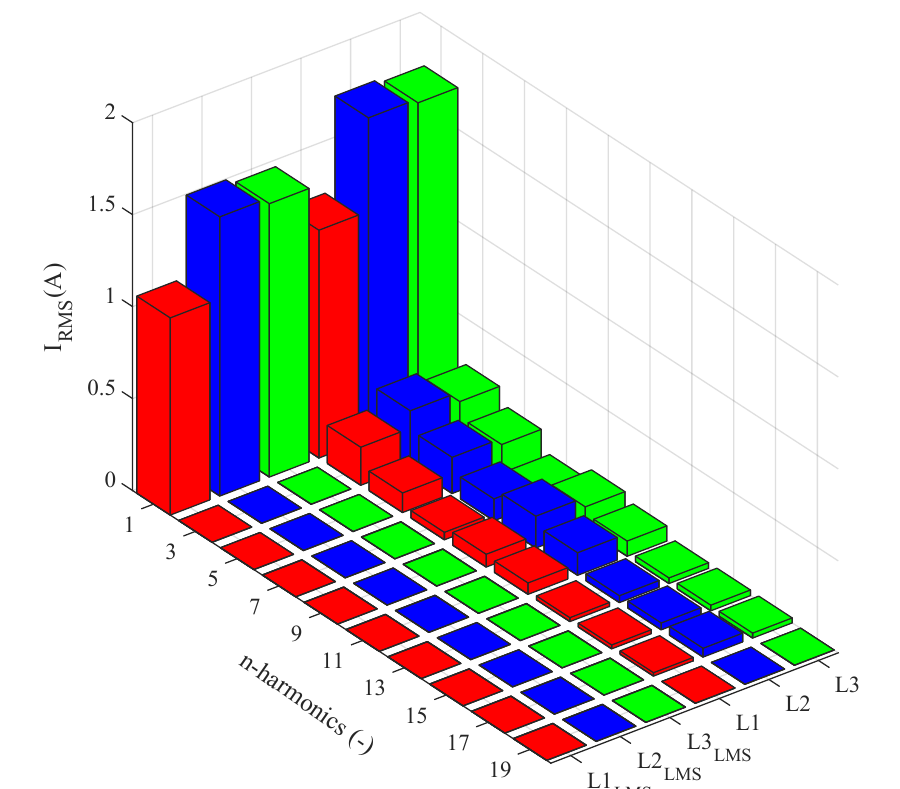
Figure 31. Field Programmable Gate Array (FPGA) Experiment; current spectra before and after application of the adaptive LMS Notch